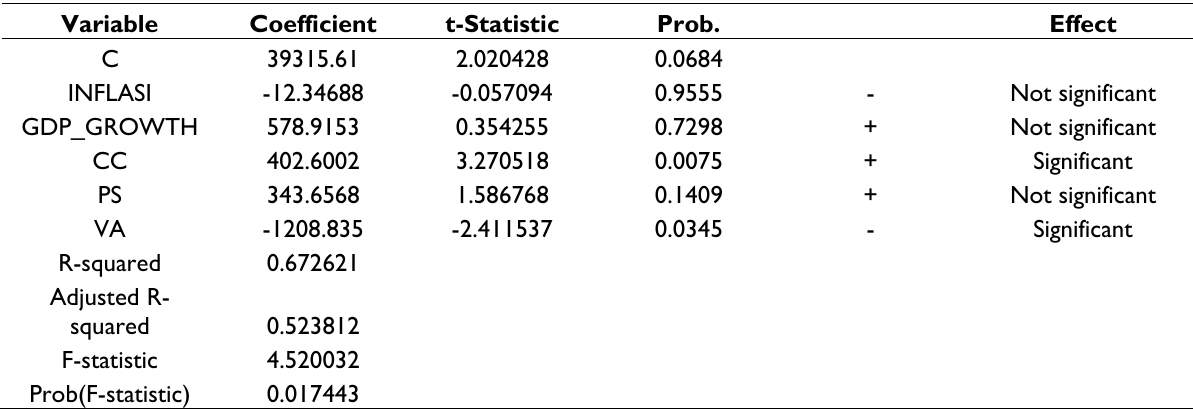
Table 7. The summary of the regression